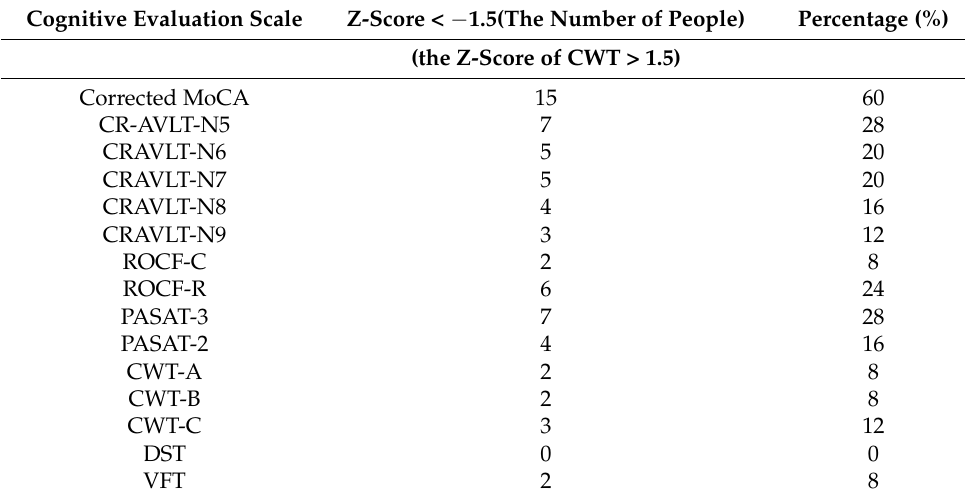
Figure 2. The percentage of acute NMOSD with cognitive impairment. Table 3. Z- Score < −1.5 of cognitive scales in acute NMOSD.